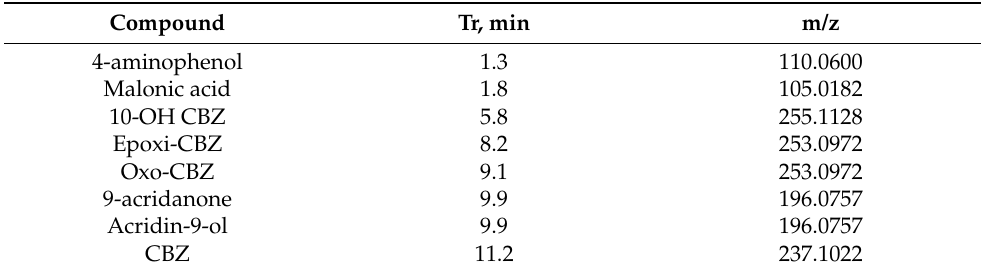
Table 1. Standards analyzed.